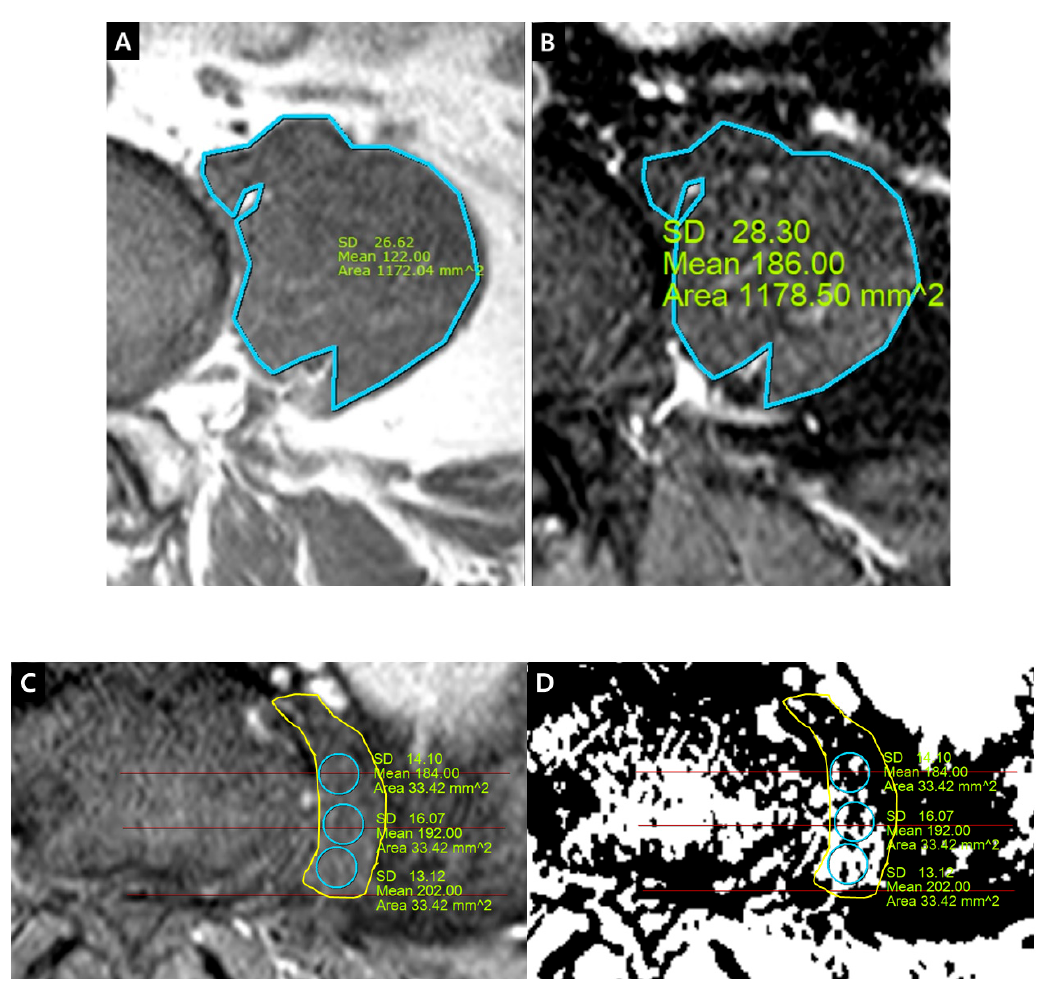
Figure 7. Signal intensity measurement of psoas muscle on fat-suppressed enhanced T1-weighted axial image. ( A , B ) Psoas1, manually-defined region of interests (ROIs); ( C , D ) Psoas2, circular ROIs.